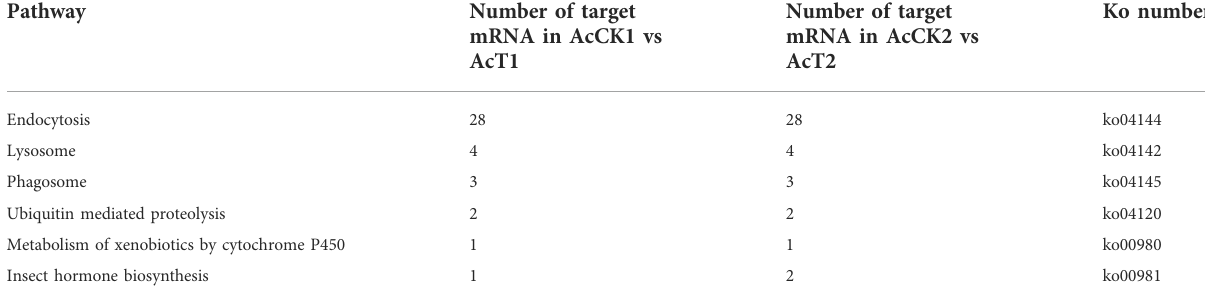
TABLE 4 Summary of cellular immune pathways enriched by DEcircRNA-targeted mRNAs within ceRNA networks. Pathway